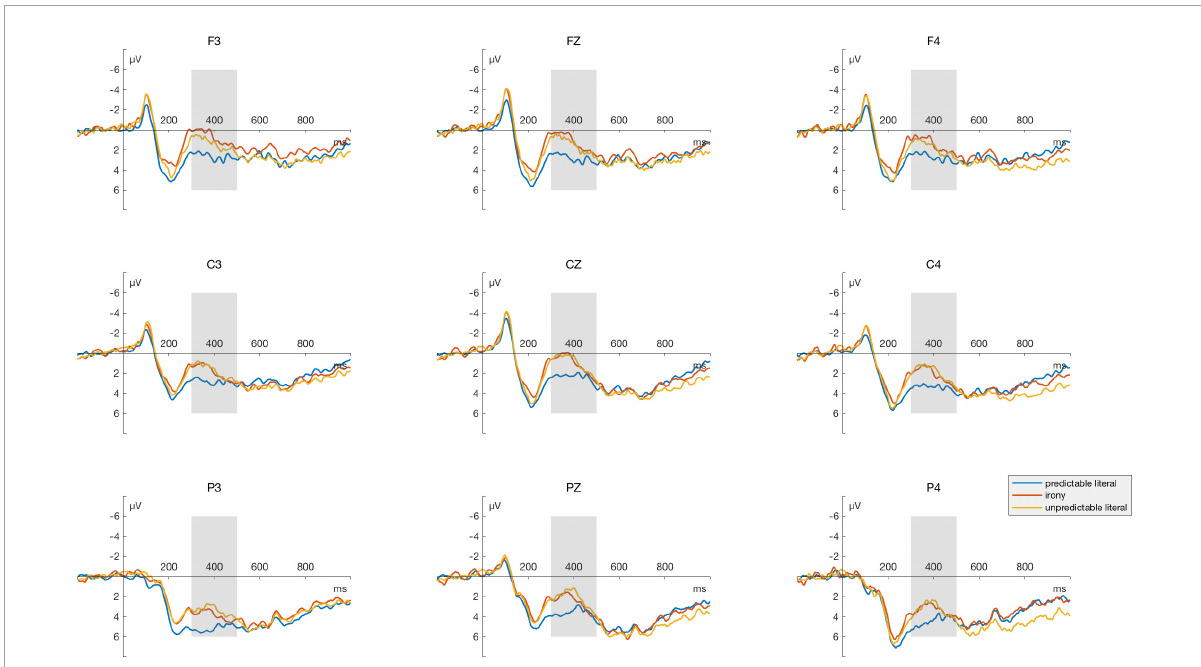
FIGURE2 Grand average event-related potentials (ERPs) analyzed for the critical words of all conditions. Grand averaged ERPs for target stimuli at Frontal, Central, and Parietal sites. The area marked by the gray bar is the 300–500 ms interval on the time axis, which is the time window of the N400 component.